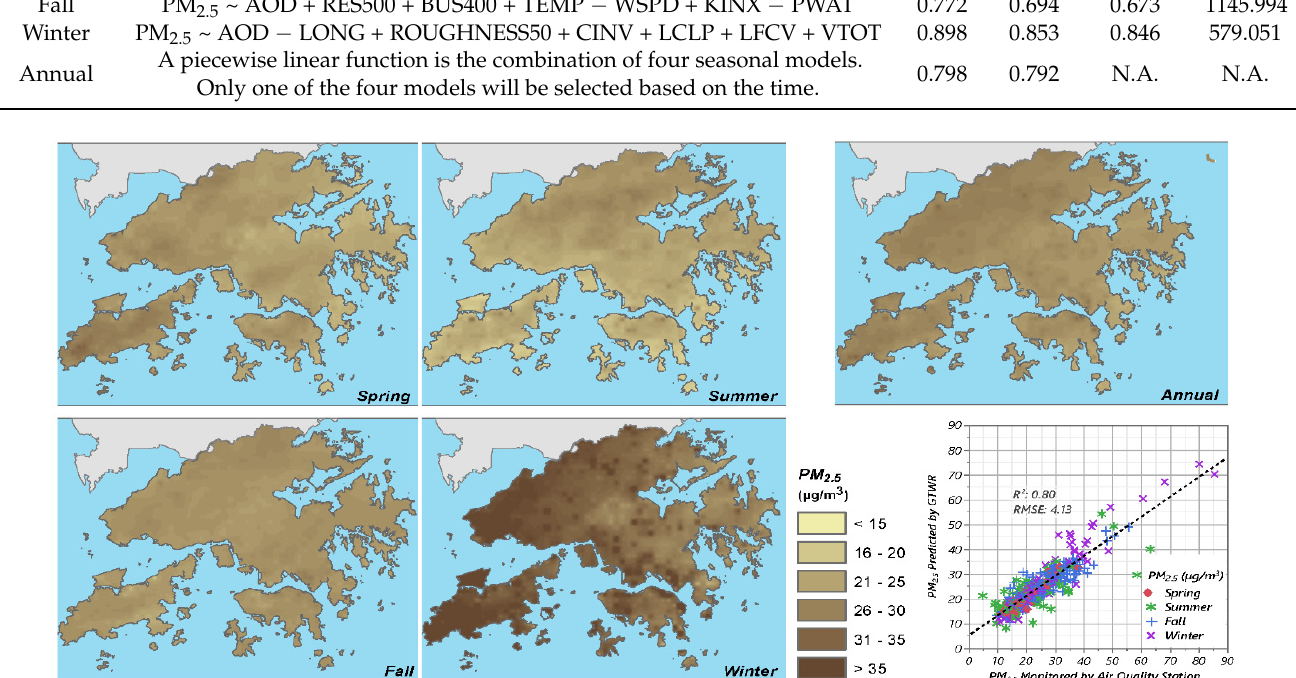
Figure 2. The four resulting maps of seasonal average and the map of the annual average of PM 2.5 concentration level. The concentration value of 35 µg/m 3 is the annual limit in Air Quality Objectives (AQOs) set out by the Air Pollution Control Ordinance (Cap. 311) of Hong Kong. The inset picture at the bottom right corner shows the actual predicted plot of the resulting models of PM 2.5 concentration level. Table 2. Summary of the resultant GTWR model structures. The math operators before each predic- tor variable indicate its correlation with PM 2.5 . “+” indicates a positive correlation; “-” indicates a negative correlation. Model coefficients are shown in Table S4 of the supplementary material.